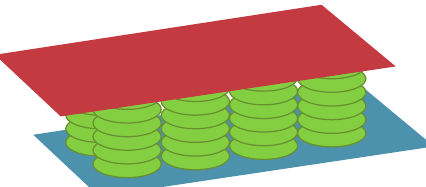
Figure 5: Ideal architecture of discotic LC-based solar